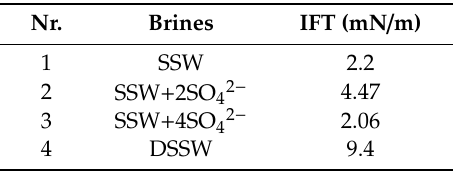
Table 7. Interfacial tension (IFT) between brines and crude oil at 22 ◦ C.